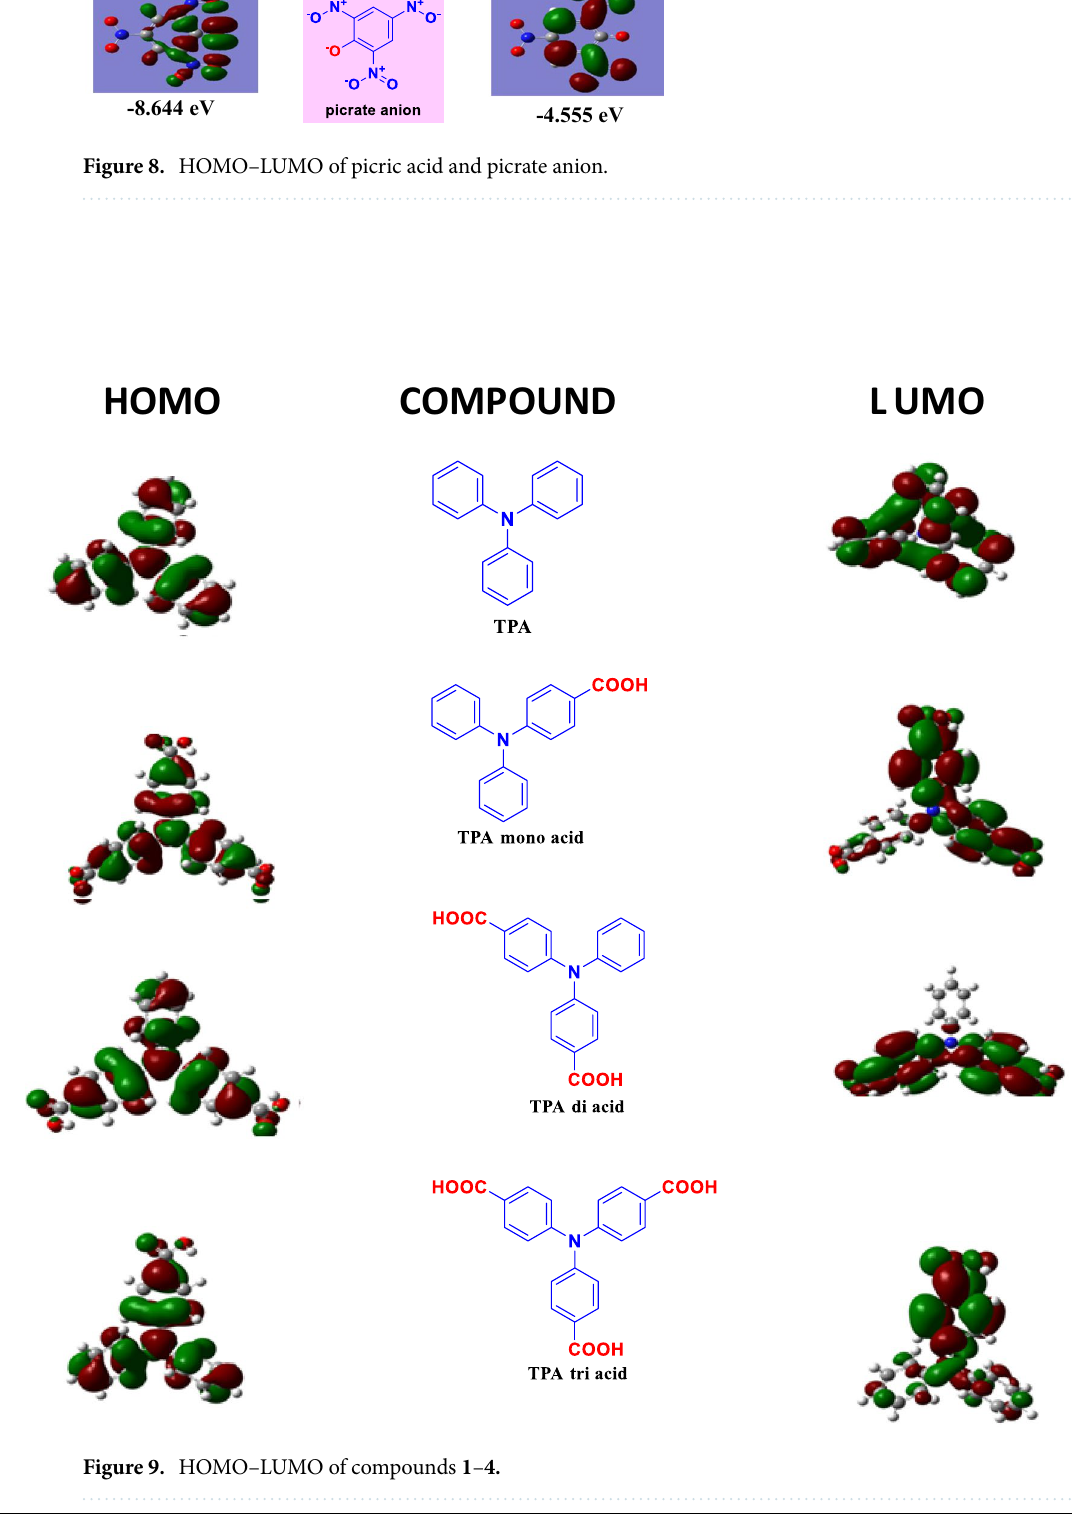
Figure 9. HOMO–LUMO of compounds 1 –